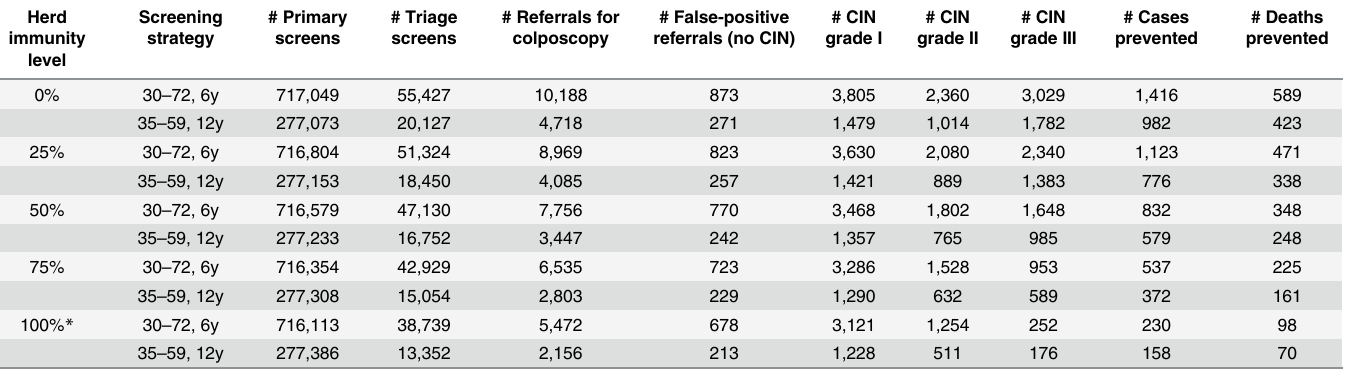
Table 2. Undiscounted health effects for unvaccinated women of primary HPV screening at ages 30 – 72 every 6 years (optimal for unvaccinated women without herd immunity) and at ages 35 – 65 every 15 years (optimal for vaccinated women), as compared to no screening. For different levels of herd immunity, results are given per 100,000 unvaccinated women.